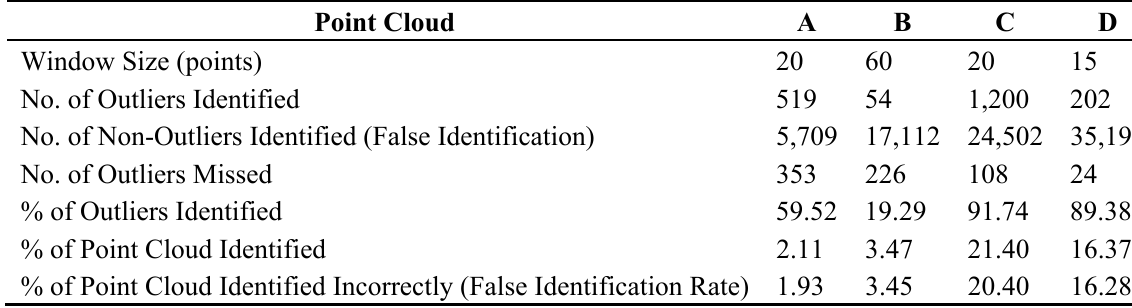
Table 2. Results from trials conducted using adjusted LiDAR ranges in the Moving Fixed Interval Smoother (MFIS) on point clouds A, B, C and D.